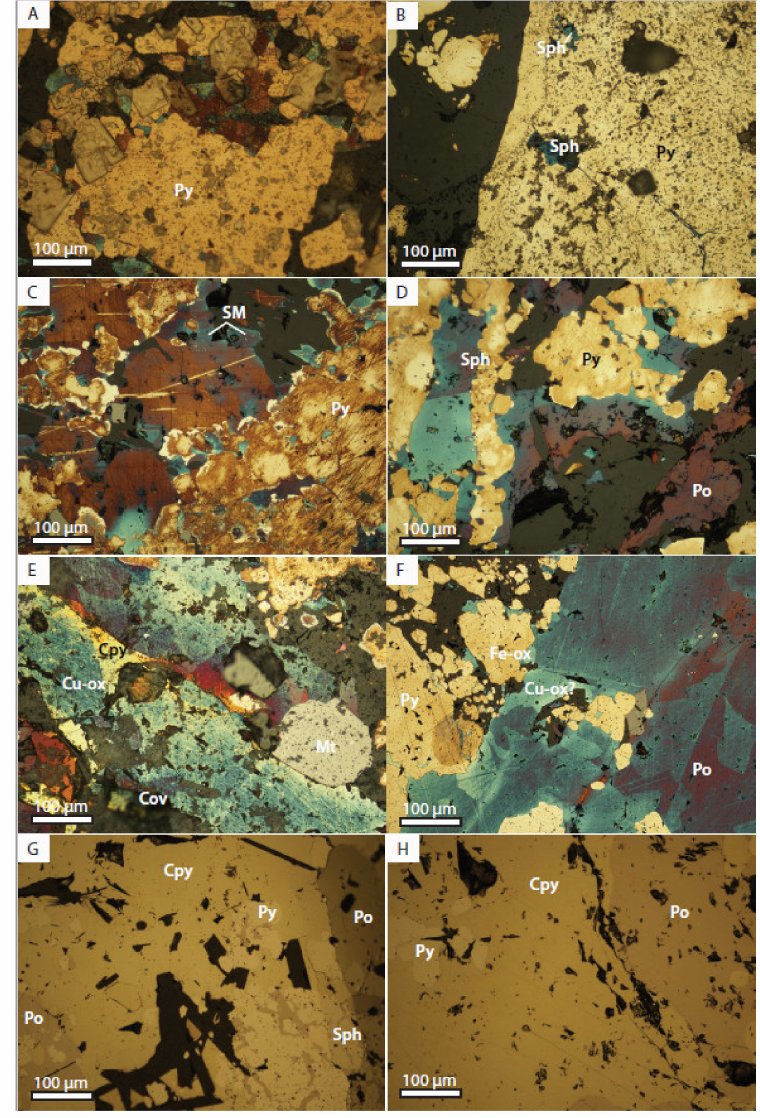
Figure 6. Microphotographs of polished thin sections from the Røros deposit after the 90-day experi- ment. The photographs ( A – H ) are taken under crossed poles, reflected light microscope and corre- spond to test conditions #1–8 (Table 1). ( A , B ) well-preserved pyrite grains (Py) with partly oxidized sphalerite (Sph) triangles (blue); ( C ) partly oxidized pyrite with secondary minerals formed on the rim of Cu-sulfides; ( D ) oxidation of sulfide mineral assemblages: pyrite (Py), sphalerite (Sph), pyrrhotite (Po), and secondary minerals likely formed on Cu-sulfides; ( E ) Intensive oxidation and the forma- tion of secondary minerals (Cu-ox) of chalcopyrite (Cpy); ( F ) relatively well-preserved pyrite and intensely oxidized sphalerite, with minor amount of iron oxides (Fe-ox); ( G , H ) micro-assemblages of well-preserved sphalerite (Sph), chalcopyrite (Cpy), pyrite (Py), and pyrrhotite (Po). Experimental conditions #7 (quartz sand, TOC ≈ 10 wt.%, carbonate buffered, infiltrated with meteoric water; initial Eh sed = 191.5 mV, pH sed = 7.86; Figure 3) did not affect the Nussir and Ulveryggen sulfides. The minerals remained well-preserved (Figure 4G and Figure 5G; Supplementary Figure S3D,E). The Røros ore minerals also remained almost unaffected, however some pyrite grains were slightly tarnished with bright blue secondary covellite and brownish iron hydroxides (Figure 6G; Supplementary Figure